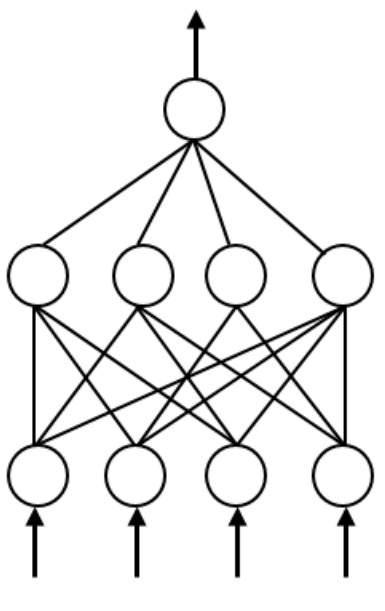
Figure 1. A typical Multi-layer perceptron (MLP) networks neural network.